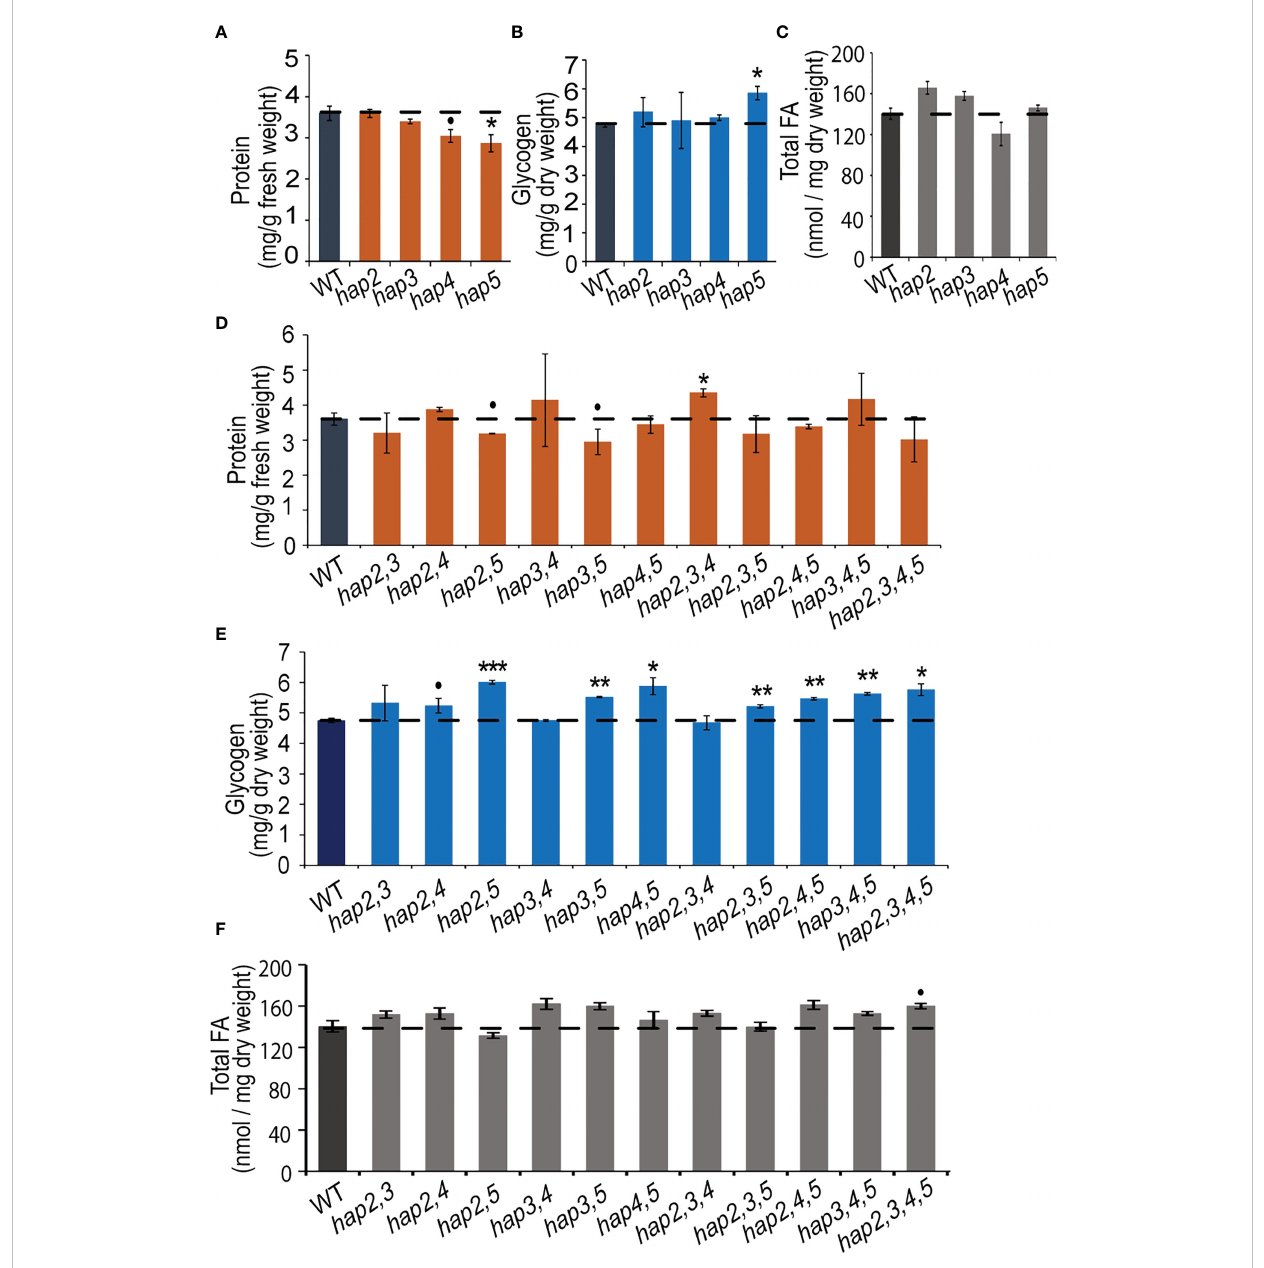
FIGURE 4 Protein, glycogen, and fatty acid content in yeast hap mutant strains. Protein (A) , glycogen (B) , and fatty acid (C) levels in yeast strains carrying hap2 , hap3 , hap4 , or hap5 mutations. Protein (D) , glycogen (E) , and fatty acid (F) levels in yeast strains carrying double, triple, and quadruple combinations of hap2 , hap3 , hap4 , and hap5 mutations. All data are mean ± SE, n = 3. Statistical signi fi cance relative to the WT strains was calculated with Student ’ s t -test and is indicated: *** P < 0.001, ** P < 0.01, * P < 0.05, (cid:129) P <